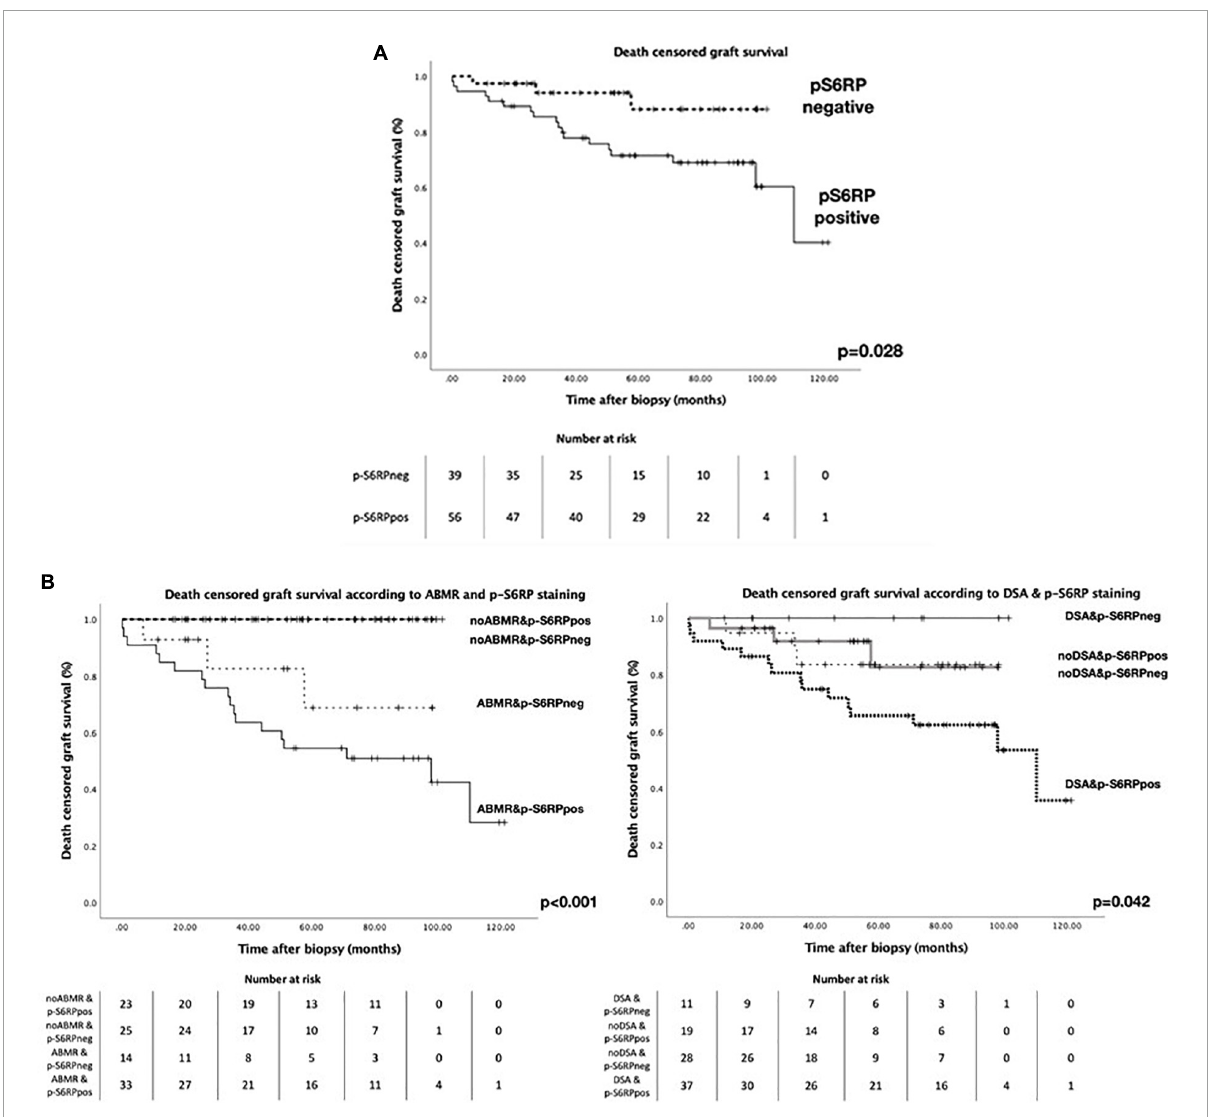
FIGURE3 Death censored graft survival in patients with biopsies with p-S6RP positive and negative staining. (A) Kaplan-Meier survival curve representing death censored graft survival in patients with positive or negative p-S6RP staining in PTC. (B Left) , Kaplan-Meier survival curve representing death censored graft survival in patients with and without ABMR diagnosis according to the p-S6RP staining in the biopsy. P -value between ABMR+ cases with positive or negative p-S6RP staining is p = 0.21. (B Right) , Kaplan-Meier survival curve representing death censored graft survival in patients with and without DSA diagnosis according to the p-S6RP staining in the biopsy. P -value between DSA+ cases with positive or negative p-S6RP staining is p = 0.043.